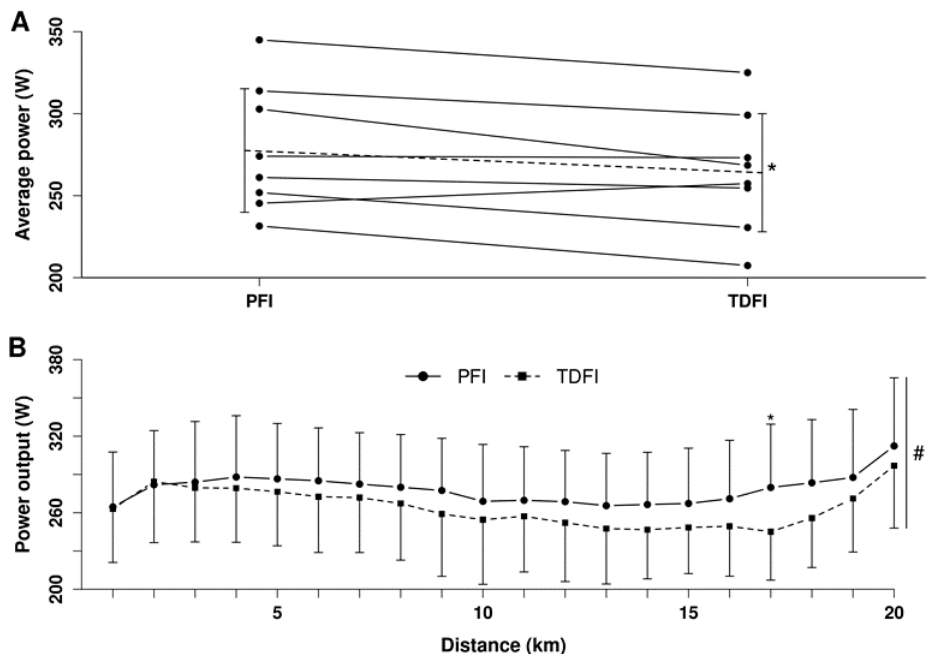
Figure 6. Average power outputs of each participant ( A ) and changes in power output ( B ) during the 20 km time-trial for the programmed (PFI) and thirst-driven fluid intake (TDFI) strategies. Dotted line represents the average of the 8 participants. * p < 0.05 for difference between conditions, # significant distance effect ( p < 0.001). When required, values are reported as means ± SD.